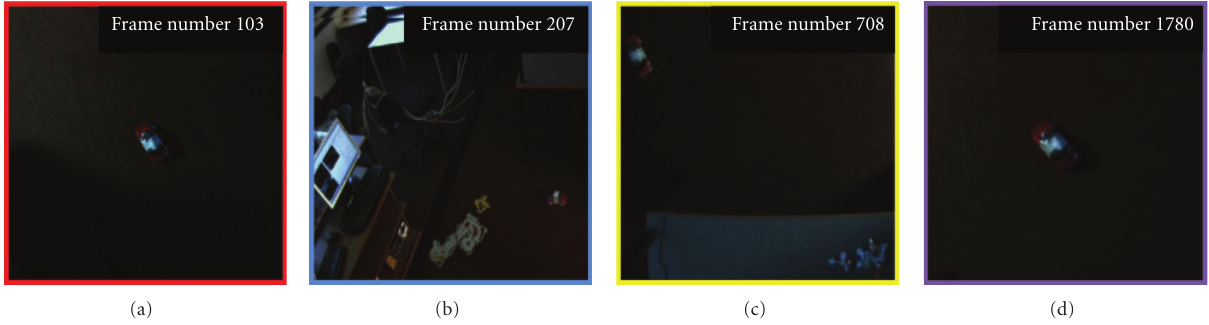
Figure 7: Sequence of images extracted from real dataset consisting of four nonoverlapping cameras. Frame numbers show the motion of the object across the network.